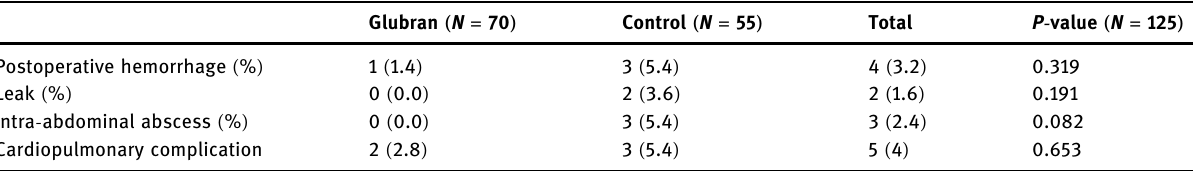
Table 5: Speci fi c postoperative complications Glubran ( N = 70 ) Control ( N = 55 ) Total P - value ( N = 125 ) Postoperative hemorrhage ( %